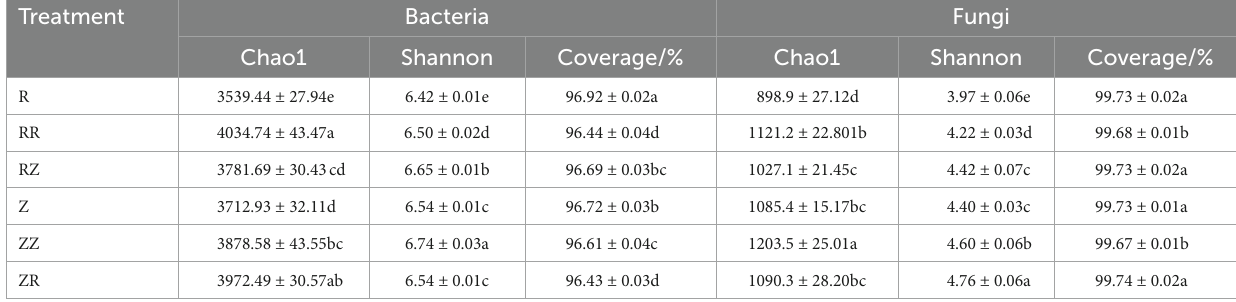
TABLE 3 Alpha diversity of the bacterial community and fungal community in different treatments with straw.